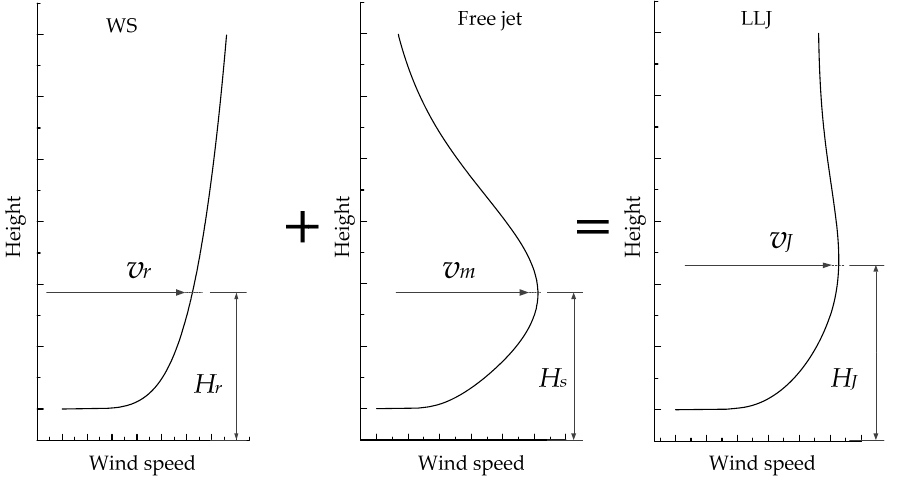
Figure 1. Schematic representation of the WS and LLJ wind profile.